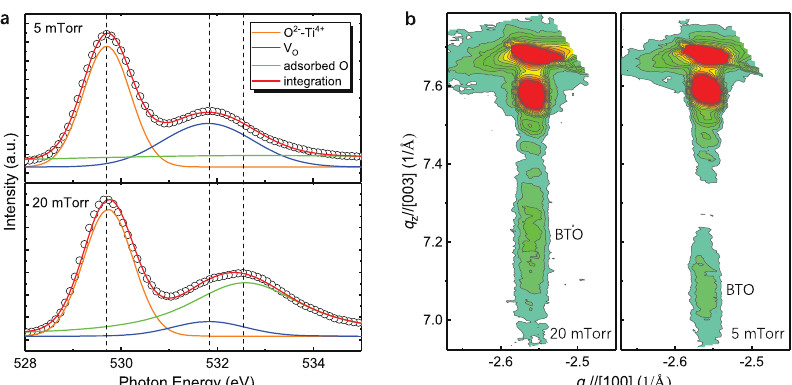
Fig. 3 Examination of oxygen vacancy population. a X-ray photoemission spectrum (XPS) of the O 1 s core level of BTO grown under 5 and 20 mTorr, respectively. The orange (centered ~529.7 eV), green (centered ~531.8 eV), and blue (centered ~532.5 eV) fi tted curves correspond to the O contributed by O 2 – bounded with Ti 4 + in BTO, oxygen vacancies (V O ), and surface-adsorbed OH – or H 2 O, respectively. b Asymmetric reciprocal space mapping (RSM) of 5- and 20-BTO fi lms near the STO (103) reciprocal lattice point. While both BTO fi lms are fully strained (inferred from the commensurate in-plane lattice constants as that of the STO substrate), the out-of-plane lattice constants are extracted as 0.424 and 0.416 nm for 5- and 20-BTO fi lms,